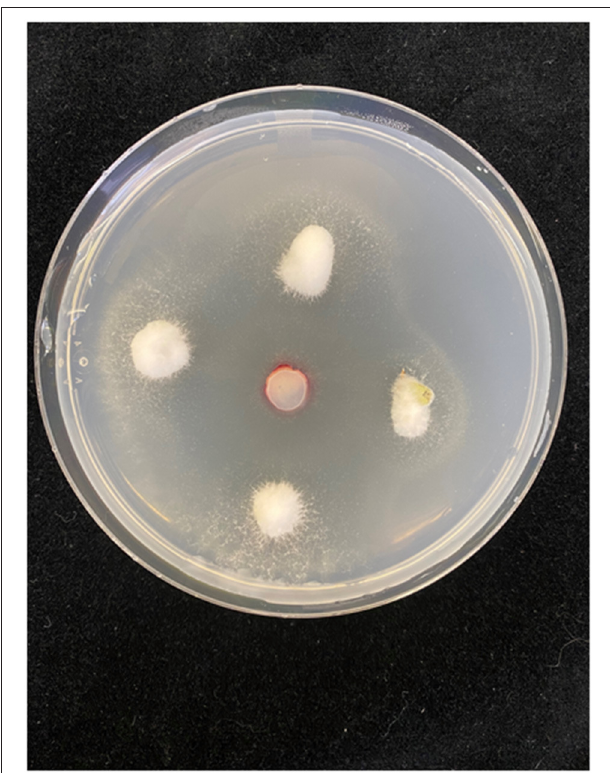
FIGURE 5 | Seed rot assay. Seed were surface sterilized then plated on water agar amended with streptomycin. Four seeds were placed equidistant from an agar plug (control) or from a mycelial plug of a culture of Fusarium sp. isolated from fiber hemp (“Katani”). After 7 days, all seeds in controls germinated, and survived transplanting to soilless medium. In Fusarium treatments, seeds were completely colonized, and only 10% of seed germinated. Seedlings did not survive after transplanting (photograph by Megan